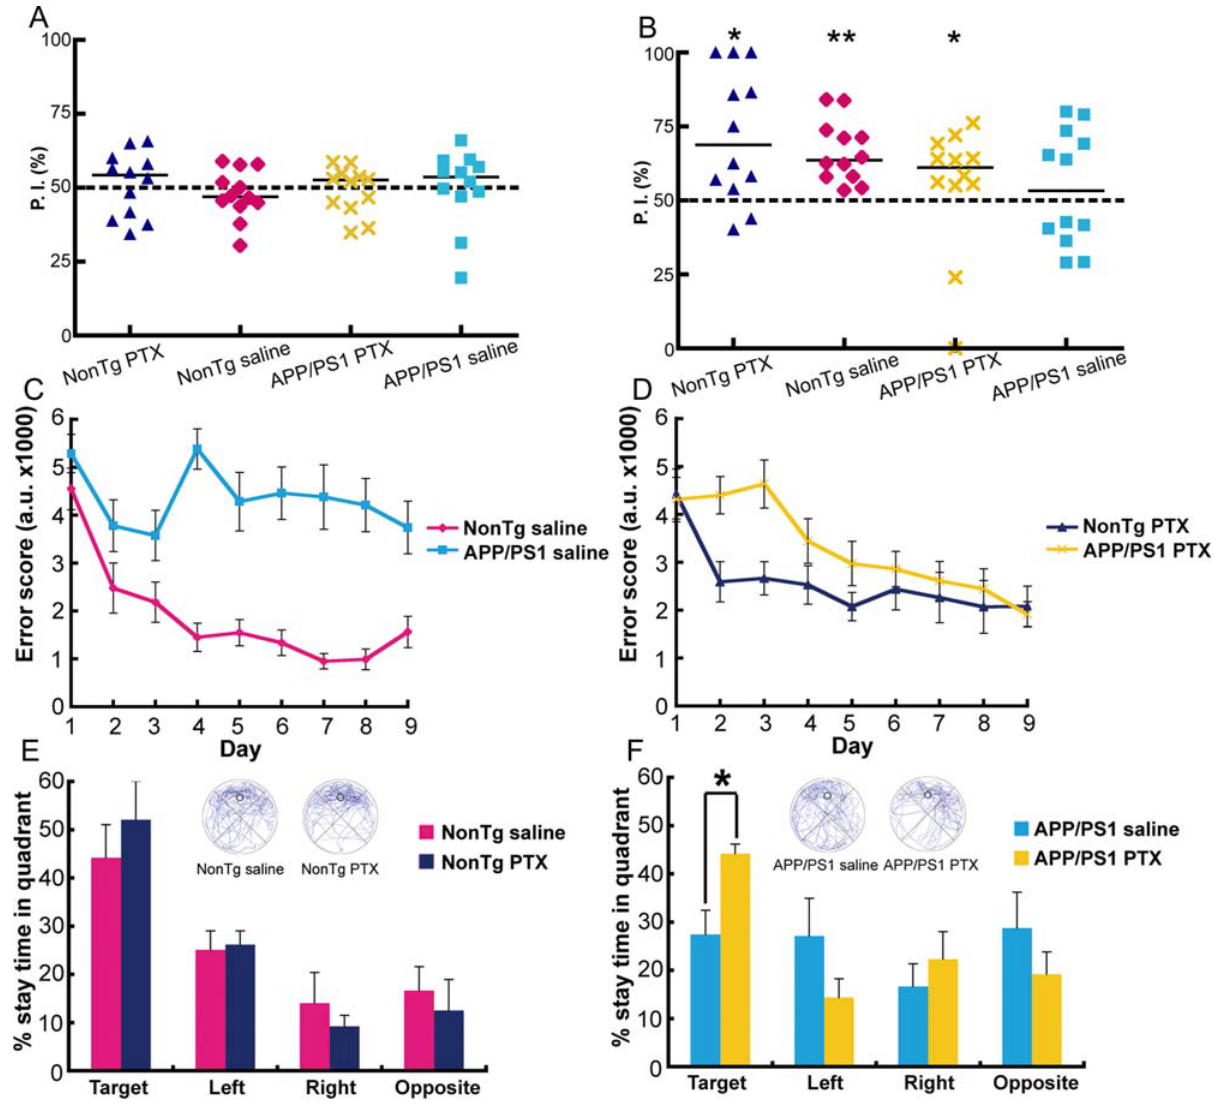
Figure 4. Memory facilitation in adult APP/PS1 mice treated with PTX. The effect of 10-day PTX treatment (at a non-epileptic dose) on short- term object recognition memory was tested with a NOR task. Long-term spatial reference memory was tested with the MWM task. (A, B) Preference indices (P. I.) during training (A) and testing (B) in the NOR task in PTX- and saline-treated nonTg and APP/PS1 mice (n=6 per group). Adult APP/PS1 mice showed partial recovery of object recognition memory with PTX treatment; *p=0.0161 and **p=0.000244, binomial analysis for accessing novel objects. (C, D) Learning session error scores of saline-treated nonTg and APP/PS1 mice (C) and PTX-treated nonTg and APP/PS1 mice (D) tested on the MWM task. In saline-treated groups, adult APP/PS1 mice showed spatial learning impairment (F[1,10]=13.73, p=0.0041; repeated measures two-way ANOVA). In PTX-treated groups, there was no significant difference between APP/PS1 and nonTg mice (F[1,10]=3.08, p=0.1099; repeated measures two-way ANOVA). (E, F) Performance during the probe trial showed significant improvement in PTX-treated APP/PS1 mice (preference in target quadrant over other quadrants; p=0.0057; the Friedman test). The swimming traces of the mice are shown in blue. The target quadrant is indicated by a circle, which represents the location of the platform during training; *p=0.0260; two-tailed Mann Whitney U test. The ages of mice were 9–13 months (10.9 6 1.6 months) for nonTg saline; 9–10 months (9.9 6 0.1 months) for nonTg PTX; 9–13 months (11.1 6 1.7 months) for APP/PS1 saline; and 9–13 months (10.8 6 1.7 months) for APP/PS1 PTX mice. The nonTg mice used in the drug-treatment experiments were wild-type littermates and controls of the APP/PS1 line.